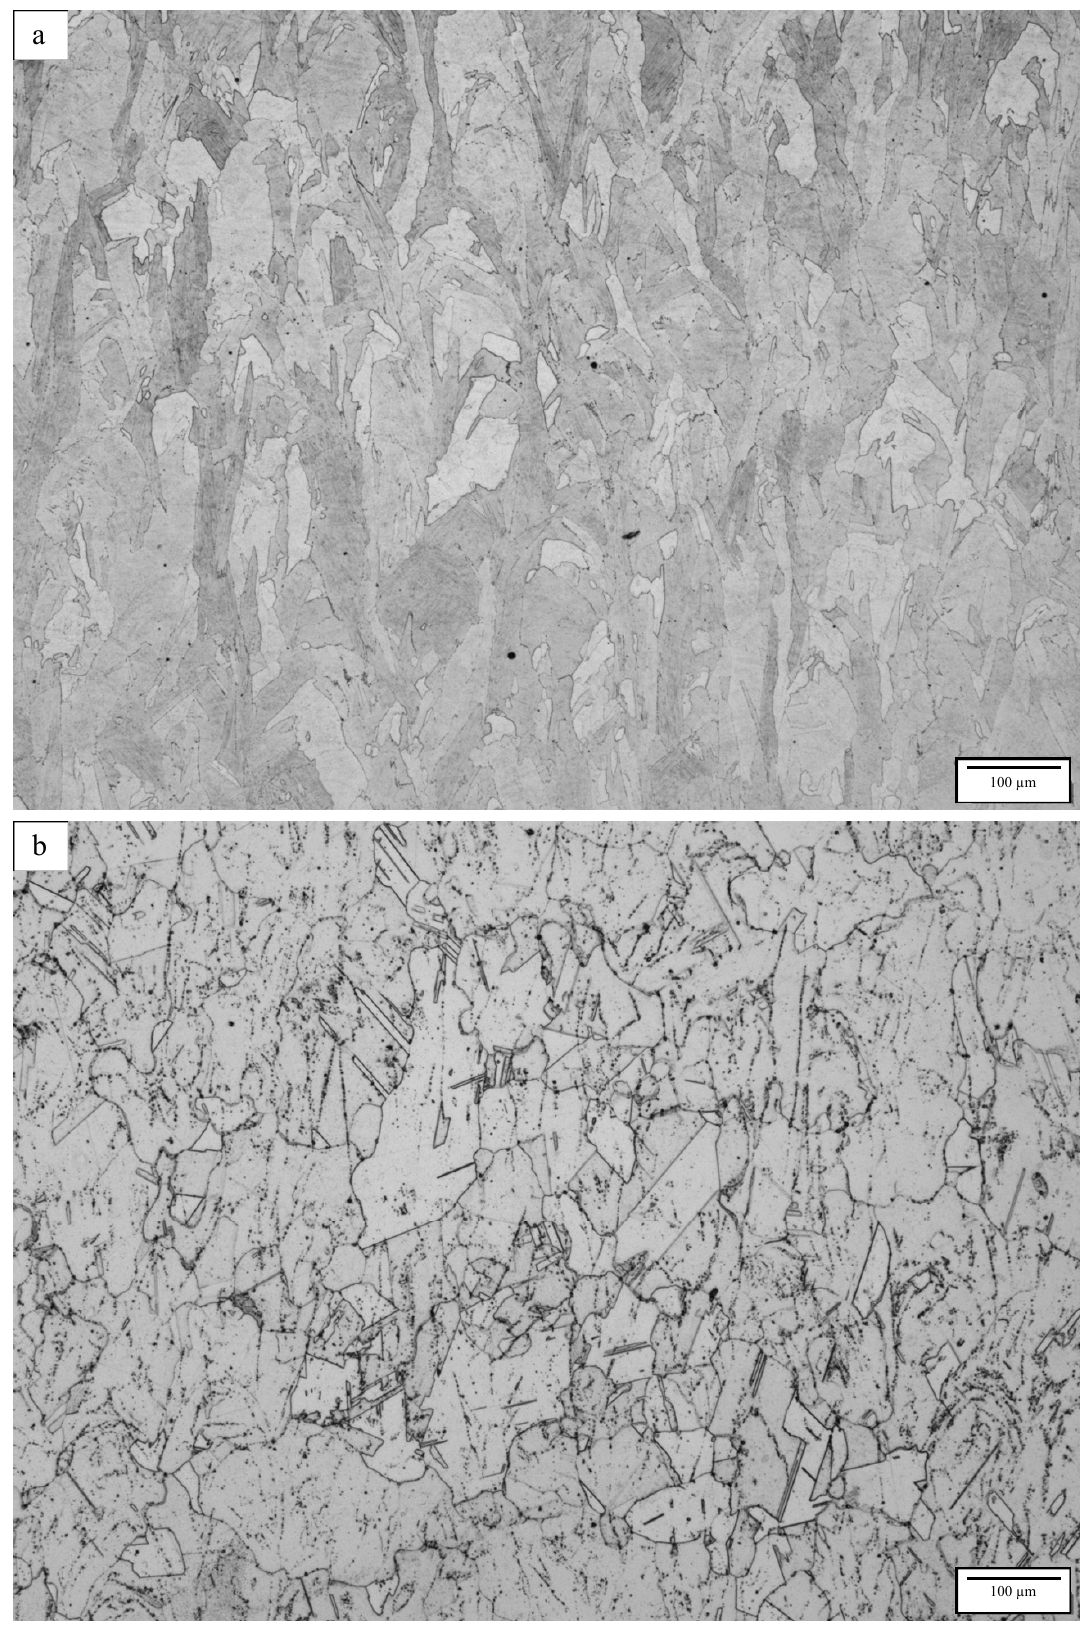
Figure 3. OM image of Variant 3 ( a ) and Variant 4.2 (Table 1) ( b ).